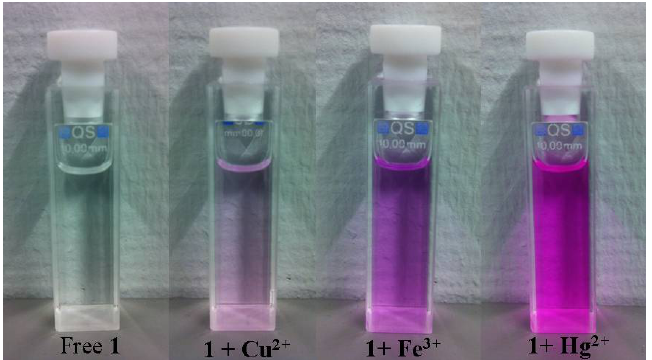
Figure 2. Photos of chemosensor 1 (5 μ M) in CH 80 equiv of Cu 2+ , Fe 3+ , and Hg 2+ ions,